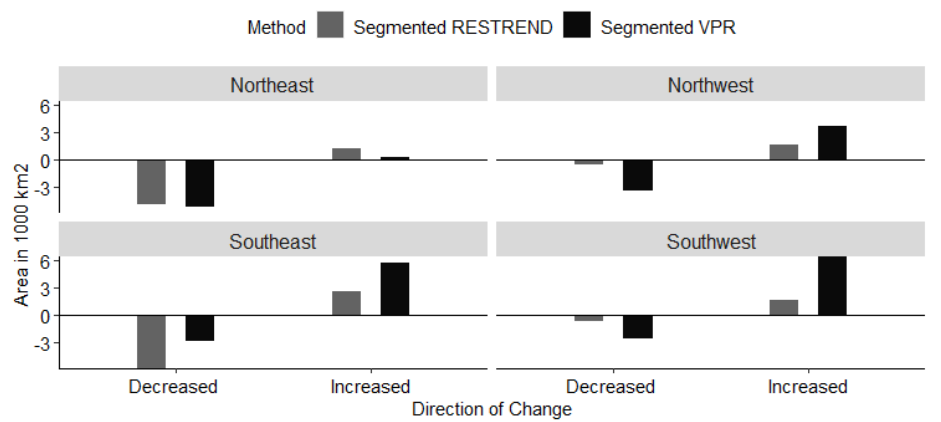
Figure 6. Area and direction of change in productivity in northeastern, southeastern, northwestern, and southwestern quadrants of New Mexico as identified using the Segmented VPR (degraded vegetation or gradual increase) and Segmented RESTREND (reversal and initiation of degradation) methods.